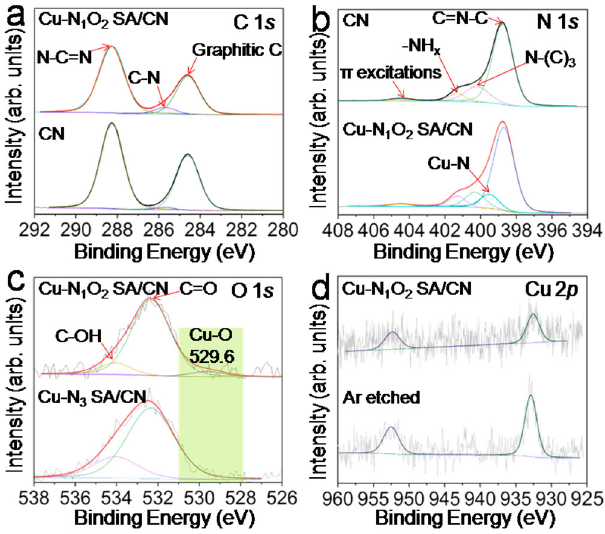
Fig.2|XPScharacterizations.a C1 s and b N1 s XPSspectraofCu-N 1 O 2 SA/CNand CN support. c O 1 s XPS spectra of Cu-N 1 O 2 SA/CN and Cu-N 3 SA/CN. d Cu 2 p XPS spectra of Cu-N 1 O 2 SA/CN.